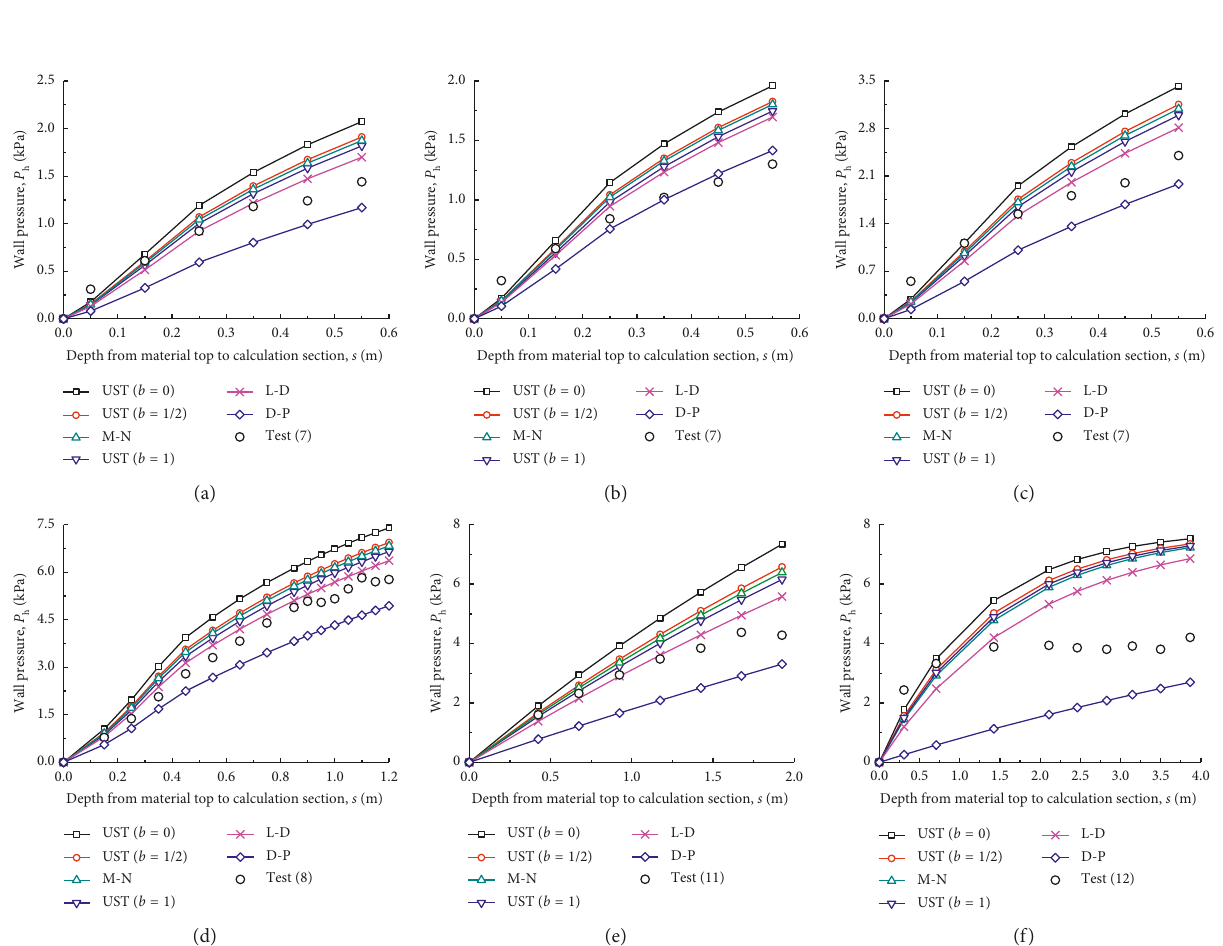
Figure 3: Comparisons of the results from six strength criteria with experimental data for deep silos. (a) Experimental data with coal from Liu and Hao [7]. (b) Experimental data with wheat from Liu and Hao [7]. (c) Experimental data with dry sand from Liu and Hao [7]. (d) Experimental data with standard sand from Zhang et al. [8]. (e) Experimental data with wheat from Ruiz et al. [11]. (f) Experimental data with dry sand from Munch-Andersen et al. [12].